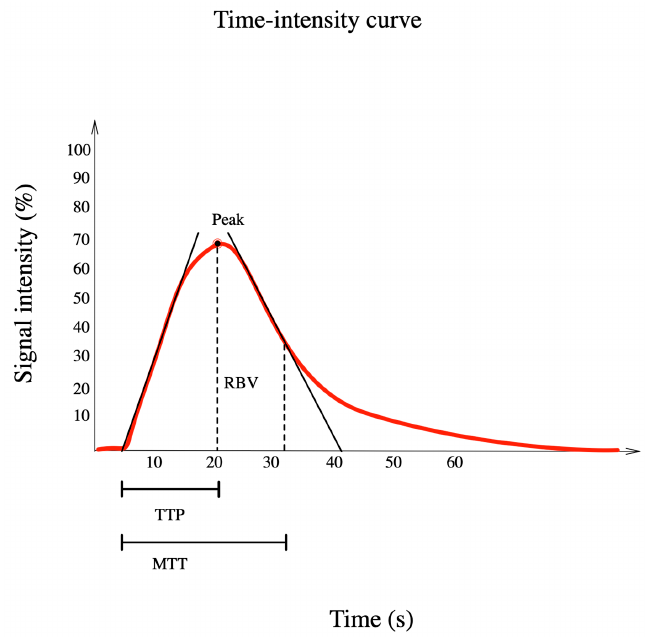
Figure 1. Representation of the time-intensity curve including parameters: TTP (time to peak) (s), MTT (mean transit time) (s) and RBV (regional blood volume) (mL). The CEUS protocol for detecting SLNs is different from the one used to evaluate breast lesions. The contrast agent is injected subcutaneously in the areolar region of the upper-outer quadrant. The LCs are visualized and seconds later (depending on the type of contrast) the SLNs. SonoVue ® , injected in amount of 0.2–0.5 mL, has a transition time of around 15–45 s from injection to its appearance in the SLN where it stays for 1 to 3 min [5]. Sonazoid ® , injected in amount of 2 mL, has an average arrival time in the SLN of approximately 5.3 min and the contrast enhancement does not decrease even over 10 min [15]. Thus, this longer transition time in the case of Sonazoid ® could be an advantage over SonoVue ® , which, due to the fast wash-out, leaves SLN very quickly and may mislead radiologists about the correct SLN. In both cases, because the microbubbles have a larger diameter than the endothelial gaps, post-injection massage for 10–30 s could be useful. Perhaps a contrast agent with smaller microbubbles would prove to be more effective and increase diagnostic accuracy [16]. c) Technical aspects The reflected signal intensity depends on the concentration of microbubbles and the frequency of the ultrasound beam. In “in vitro” studies, most of the echogenicity is pro- vided by bubbles with a corresponding resonance frequency of around 3 MHz [17]. This